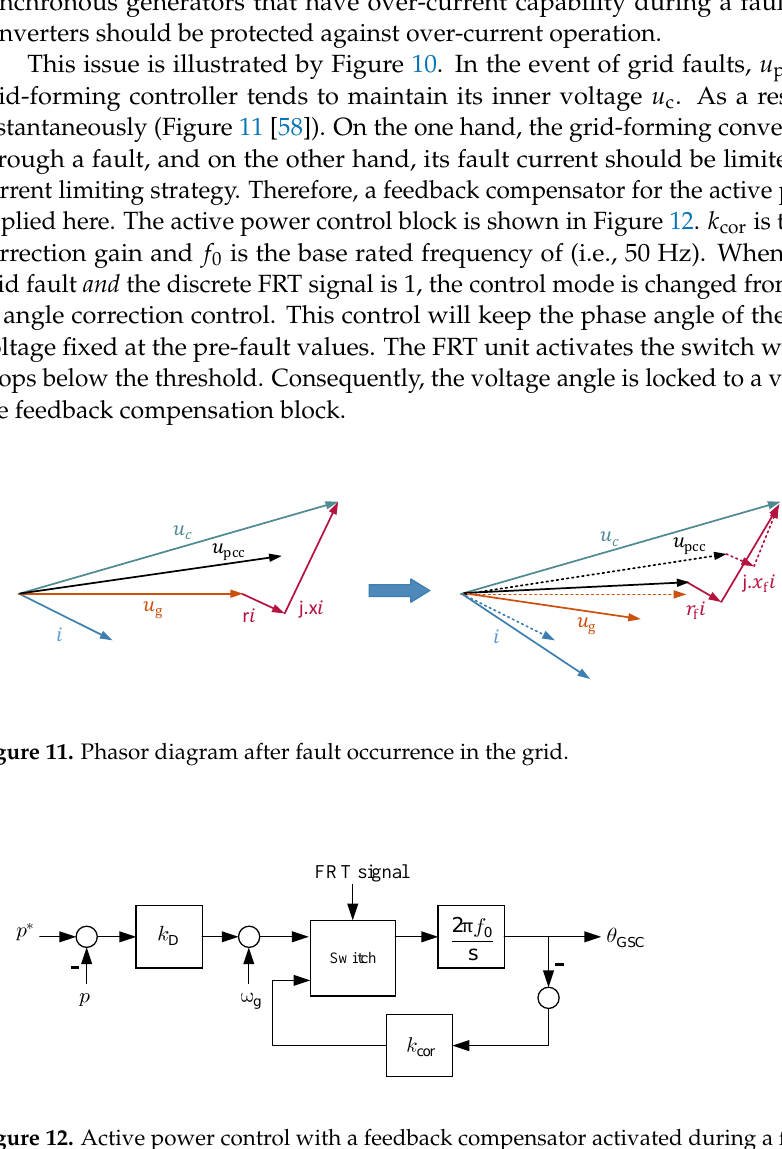
Figure 12. Active power control with a feedback compensator activated during a